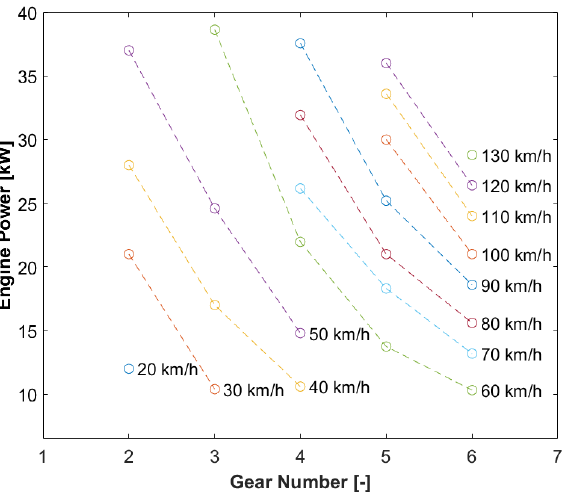
Figure 1. Stock rule-based algorithm extracted from experimental evidence.